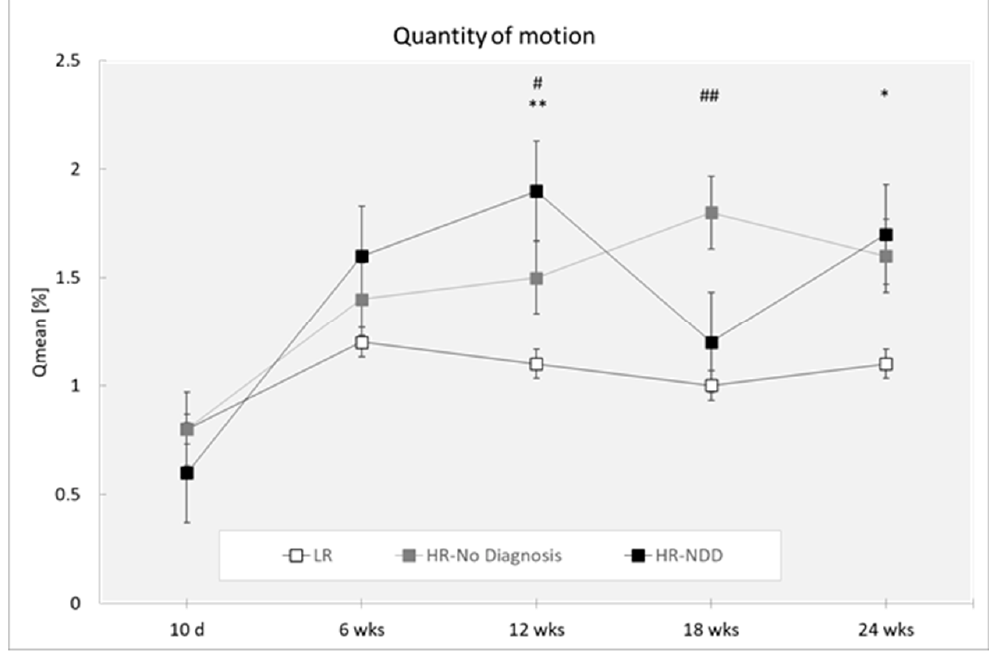
Figure 2. Quantity of motion in a 3-min session, measured at 10 days and 6, 12, 18, and 24 weeks in three groups of infants (LR, n = 53; HR-no diagnosis, n = 32; HR-NDD infants, n = 18). d = days; wks = weeks. Data are expressed as mean ± SEM. * p < 0.05 and ** p < 0.01 between HR-NDD and LR infants; # p < 0.05 and ## p < 0.01 between HR-no Diagnosis and LR infants.